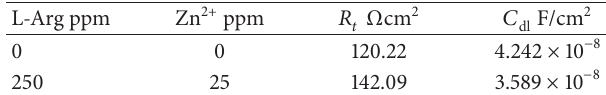
Table 6: Impedance parameters of carbon steel immersed in sea water in the absence and presence of inhibitors obtained by AC impedance spectra.